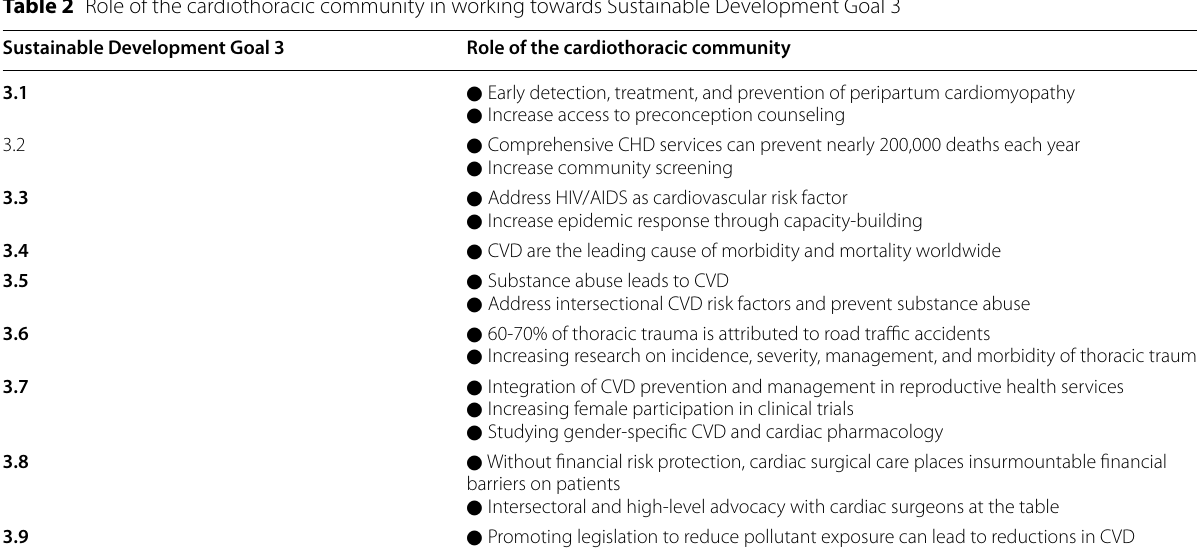
CVD cardiovascular diseases